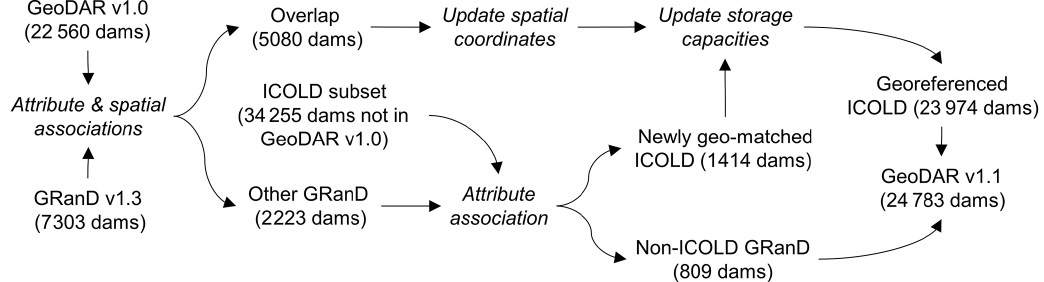
Figure 5. Schematic procedure of harmonizing GeoDAR v1.0 and GRanD v1.3 to form GeoDAR v1.1 Text in roman indicates applied or produced datasets, and text in italics indicates methods or